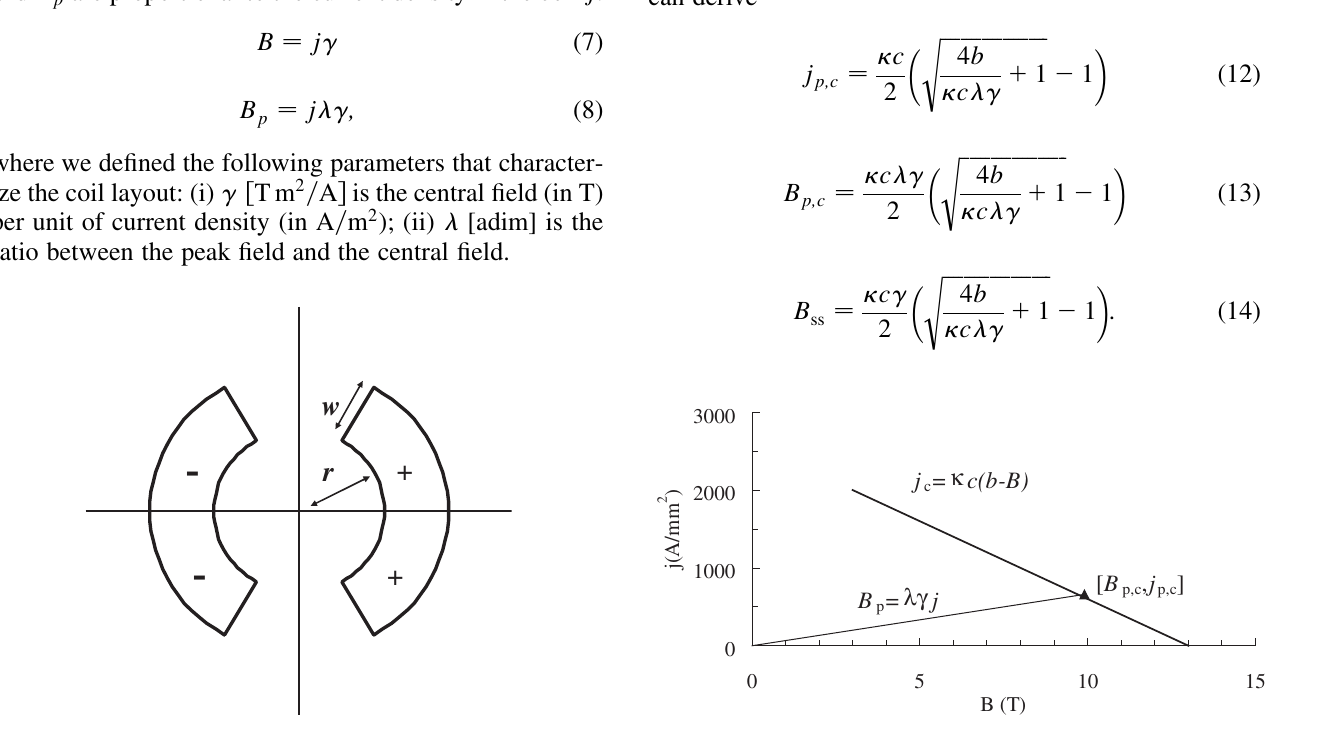
FIG. 2. Layout of a 60 (cid:12) sector coil for a dipole of aperture radius r and coil width w .